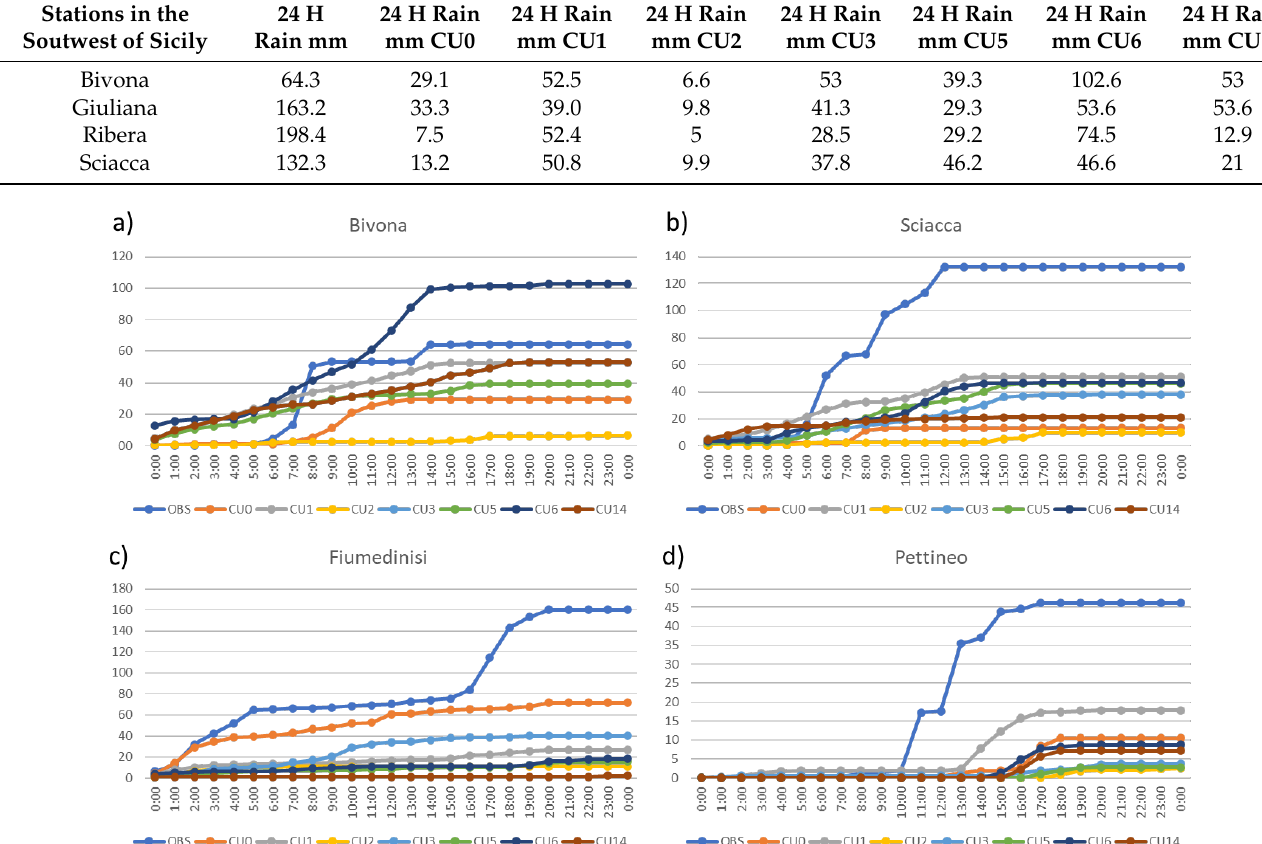
Table 3. The forecasted rainfall data and observed data provided by the 4 stations in the southwest of Sicily. Stations in the